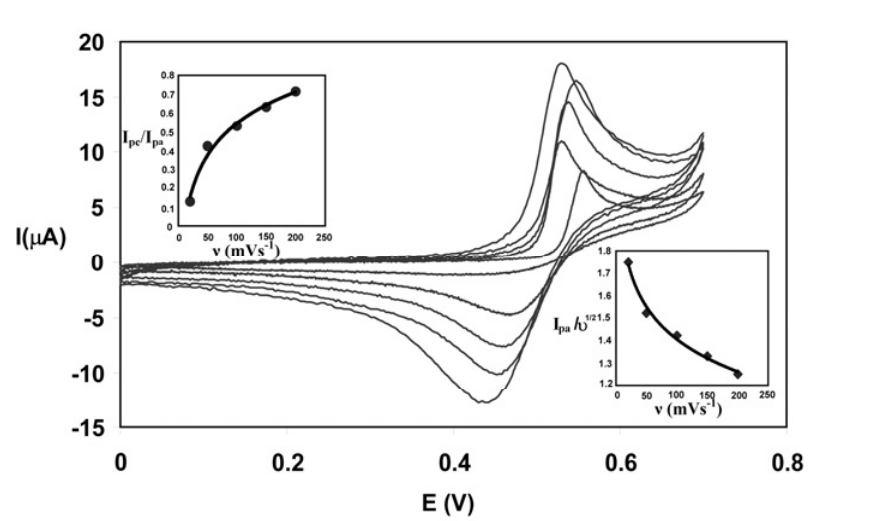
Figure 2. Cyclic voltammograms of 1×10 -3 M sodium iodide in the presence of 1×10 -3 M phenol at GC electrode, at various scan rates: 20, 50, 100, 150, 200 mVs -1 . Inset: variation of peak current function (I / υ 1/2 ) (right) and peak current ratio (I pa